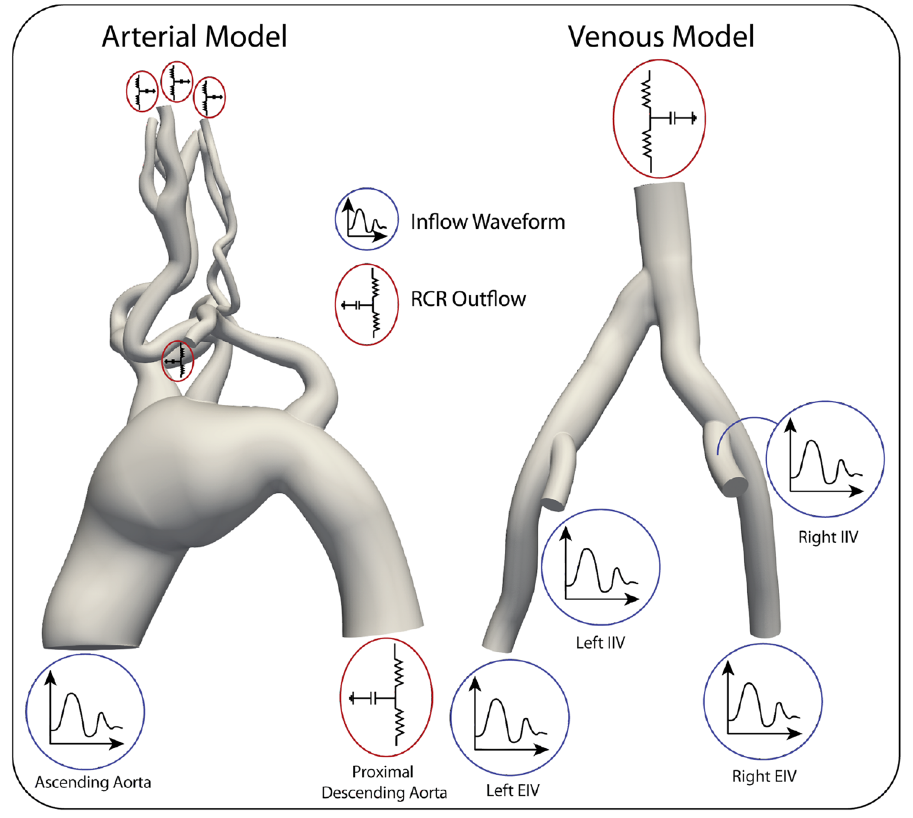
Figure 1. Computational domains of the patient-specific arterial model (Left) and venous model (Right). Inflow and outlet boundary conditions are specified as either a prescribed inflow waveform or reduced order Windkessel